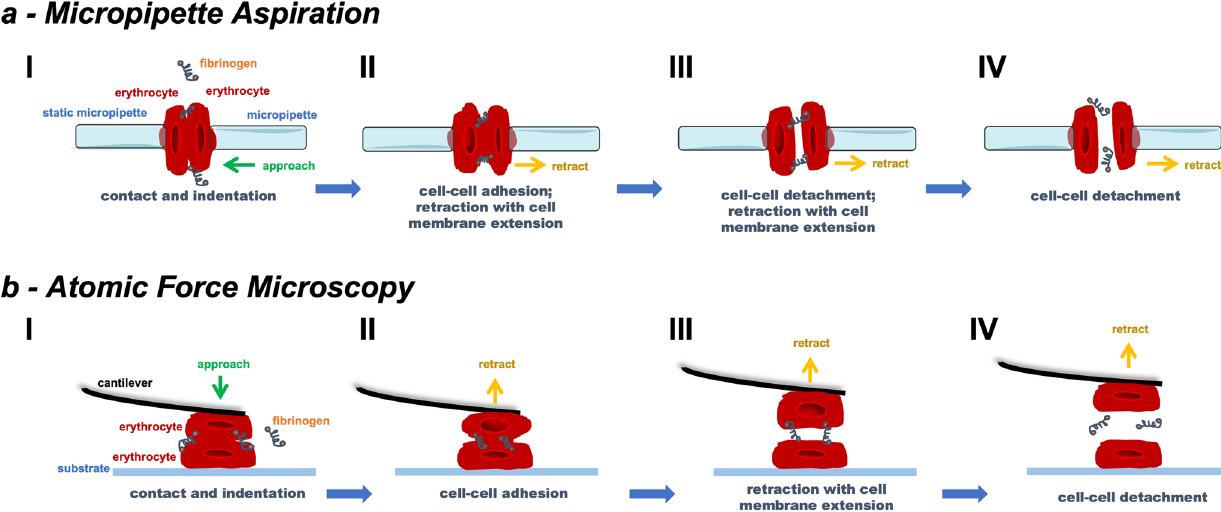
Fig. 1 Schematic experimental setup representation of the erythrocyte – erythrocyte adhesion experiments carried out using micropipette aspiration and atomic force microscopy. Using the micropipette aspiration technique ( a ), a negative pressure (suction) is applied to catch an erythrocyte in each micropipette. One of these micropipettes (depicted as the one on the left side of each panel from I to IV) is kept static. The piezo-driven micropipette, with an attached erythrocyte, approaches the other erythrocyte on the static micropipette, until a certain contact force is reached (I). Then, during the retraction of the right side pipette, cell – cell adhesion may occur, leading to the pulling of the surface of the erythrocyte from the left side when the erythrocyte from right side micropipette is being moved away from it (II and III), until the complete erythrocyte – erythrocyte detachment is reached (IV). Using atomic force microscopy (AFM) ( b ), the tipless cantilever with an attached erythrocyte is approached to other erythrocyte on the substrate, until a certain contact force is reached (I). Afterwards, during retraction, cell – cell adhesion may occur, causing the cantilever to adhere to the sample up to a distance beyond the initial contact point (II). When the applied force overcomes the cell – cell interaction forces, the cantilever pulls of sharply (III), before totally breaking the cell – cell contact and complete the erythrocyte detachment